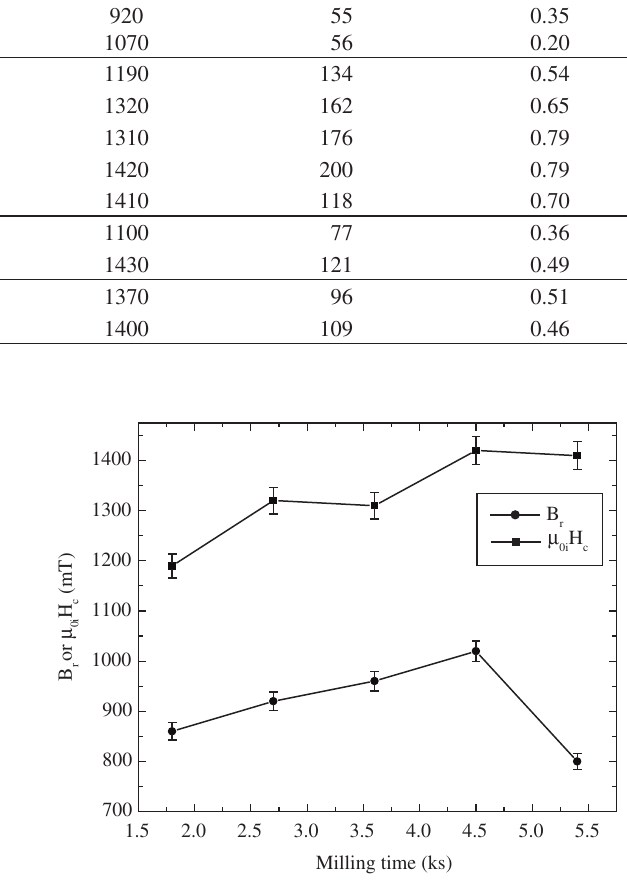
Figure 5. Variation of remanence and intrinsic coercivity with milling time for 200 rpm milling